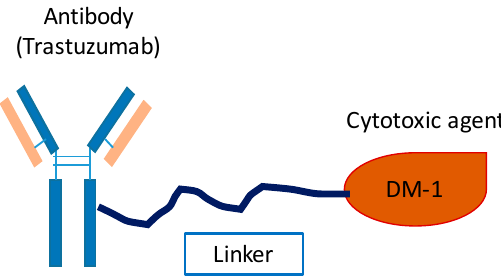
Figure 9. Molecular structure of T-DM1. The monoclonal antibody (trastuzumab) was conjugated with a cytotoxic agent (emtansine, which is also named DM1) through a thioether linker.